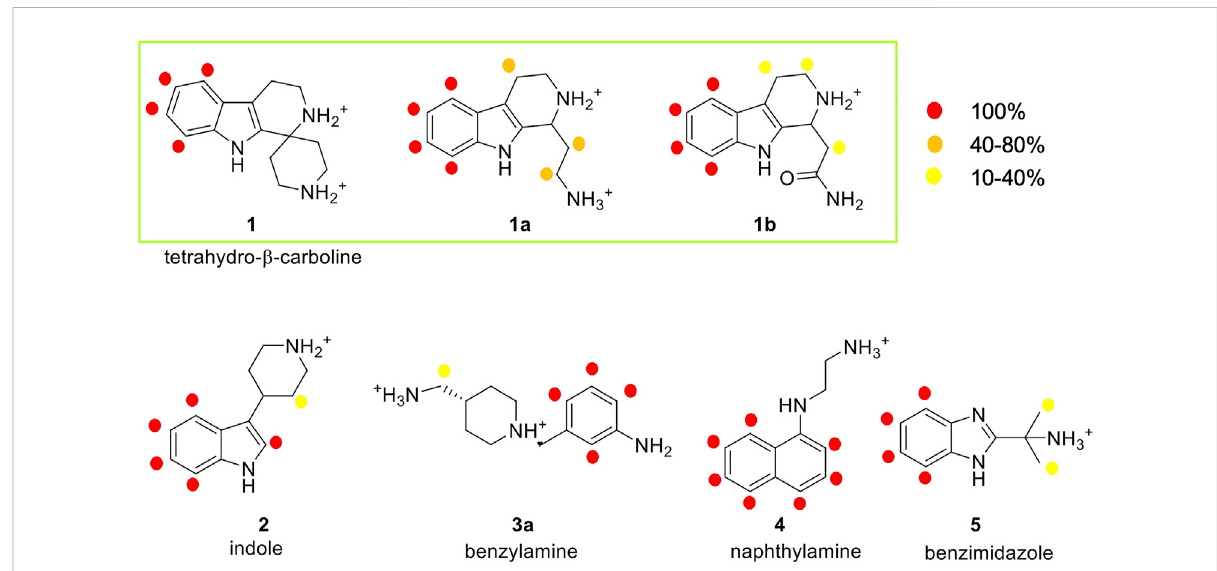
FIGURE 5 Analysis of the STD experiments for the seven selected fragments with the E-cadherin-EC1-EC2 construct. STD spectra were acquired irradiatingat − 0.1 ppmandwithasaturationtimeof2.94 s.Foreachfragment,therelativeSTDeffectsareconveyedbycolorcode:100%relativeSTD is reported in red, values between 40 and 80% in orange, and values between 1 and 40% in